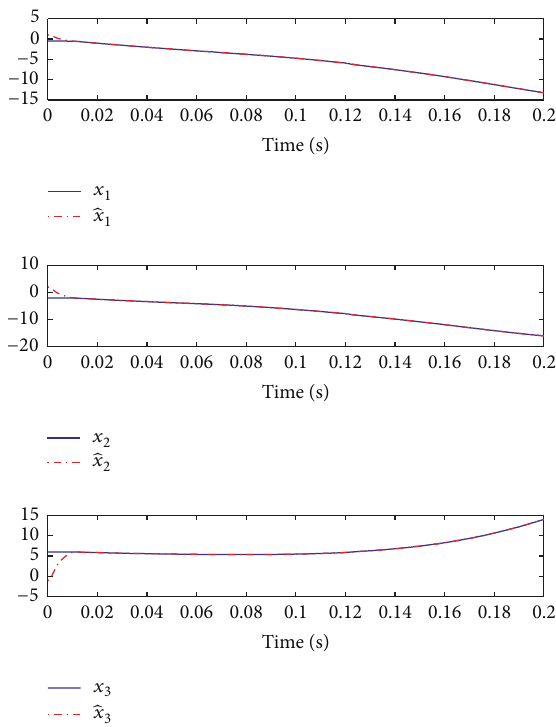
Figure 5: State responses of both master and slave systems.